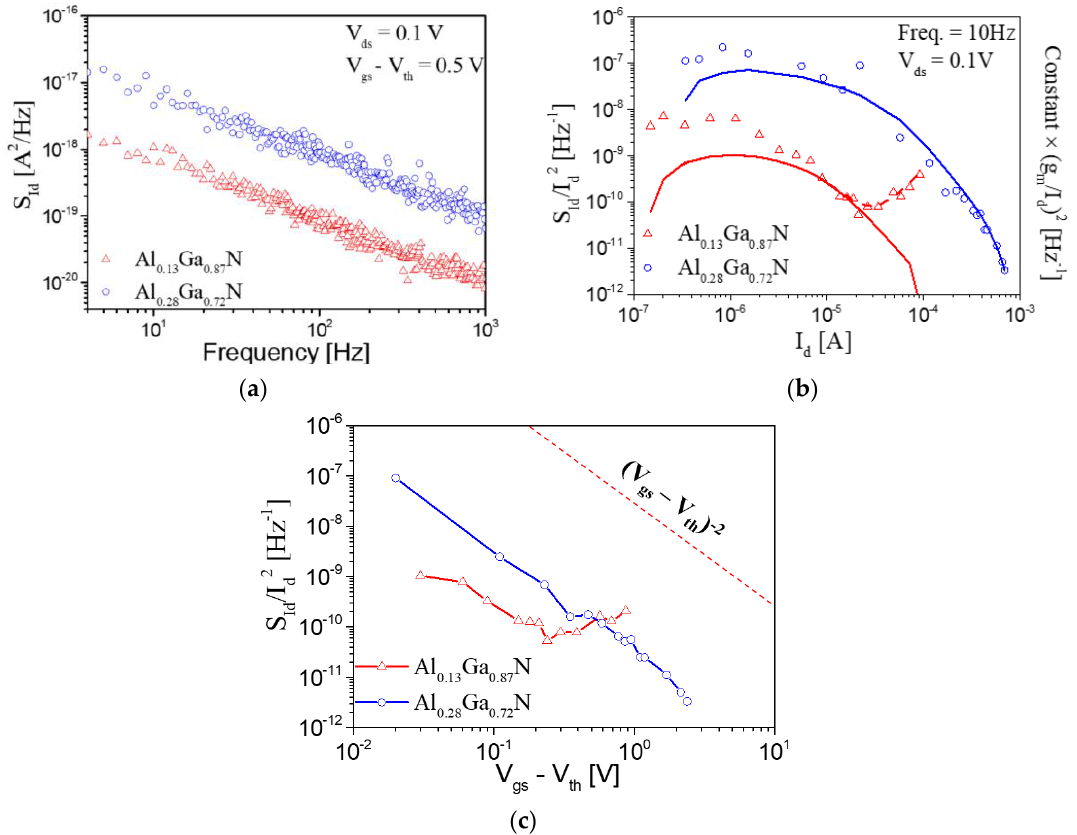
Figure 3. ( a ) S Id versus frequency at the gate overdrive voltage (V gs –V th ) = 0.5 V; ( b ) S Id /I d2 (left scale) and (constant × (g m /I d ) 2 ) (right scale) according to drain currents.; ( c ) dependence of S Id /I d2 on (V gs –V th ) in the device with the Al composition of 13% (red triangle) and 28% (blue circle), respectively. The corresponding solid lines in ( b ) show their (g m /I d ) 2 for all devices and the red dashed line indicates (g m /I d ) 2 + S Rsd (I d /V d ) 2 in Al 0.13 Ga 0.87 N HEMT (V ds = 0.1 V and ƒ = 10 Hz).